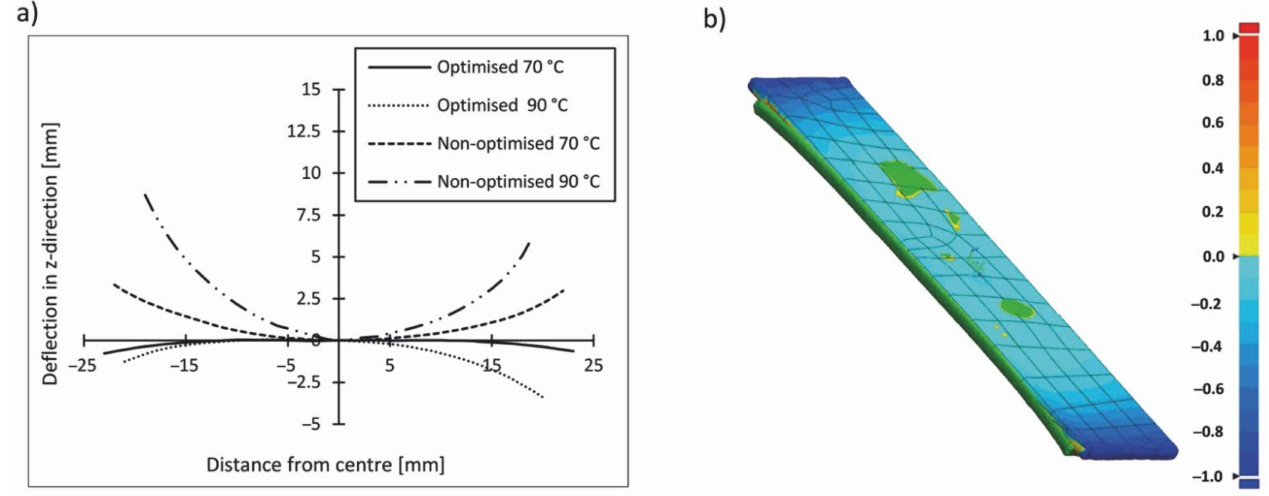
Figure 18. ( a ) Deflection in vertical direction of 3D printed test sample, ( b ) colour matching 3D plot of the sample transformed 70 ◦ C with respect to